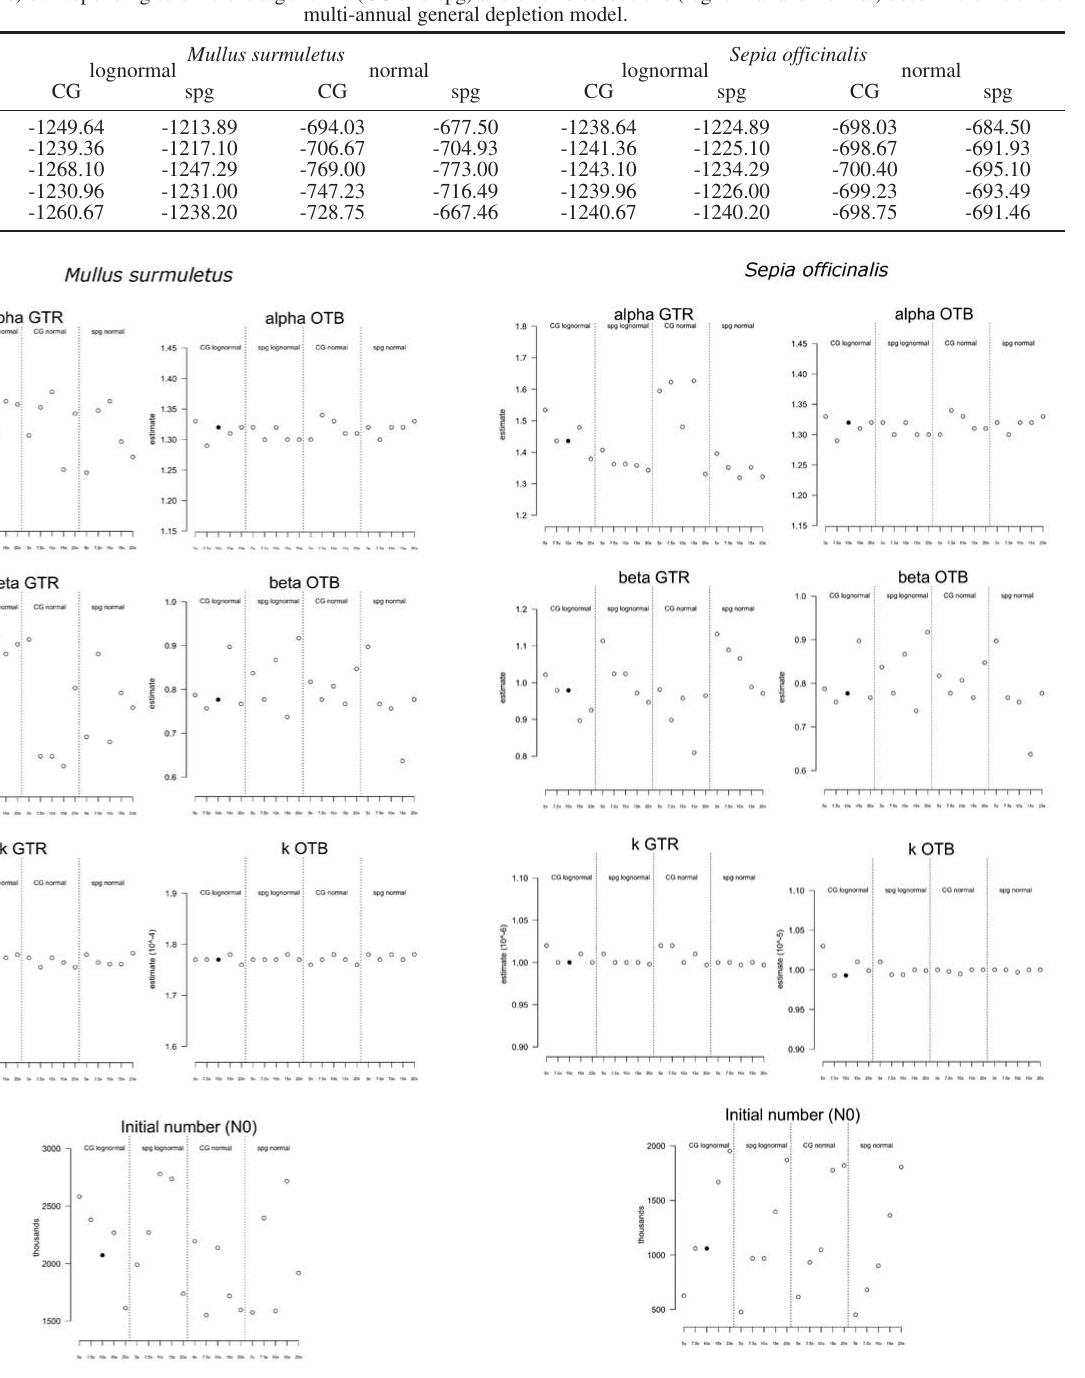
Fig. 5. – Estimates of parameters a of the Vilanova i la Geltrú fishery, under different scenarios and op- timization algorithms (refer to Table 1). The parameters estimated for the model with the lowest AIC are shown with filled